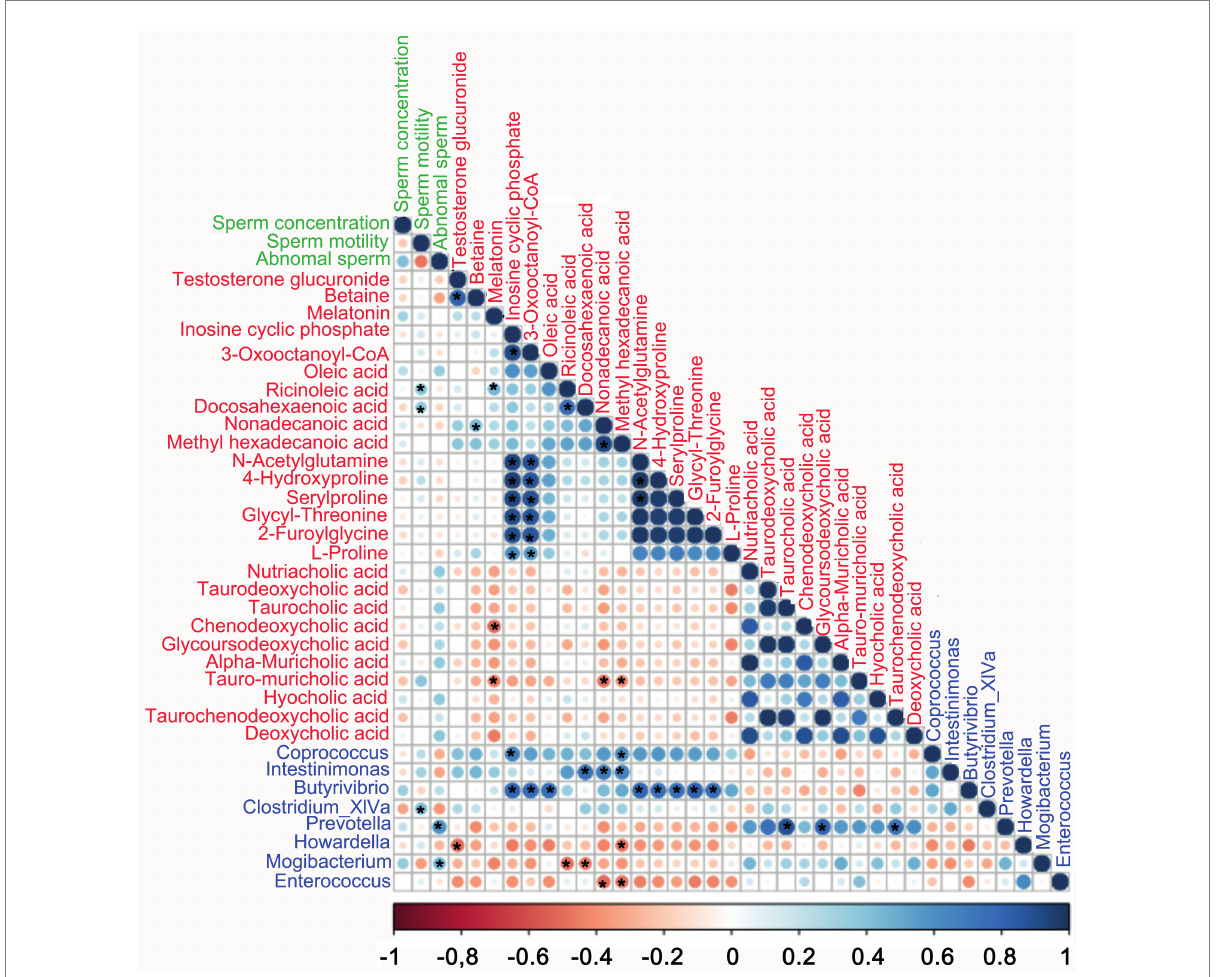
FIGURE 6 Correlations among fecal microbes, blood metabolites, and semen quality parameters. The color of the circle represents a positive or negative correlation, and the size of the circle represents the strength of the correlation. (large circle = stronger correlation, color green represents semen quality parameters, the color red represents blood metabolites, the color blue represents fecal microbes). * p <